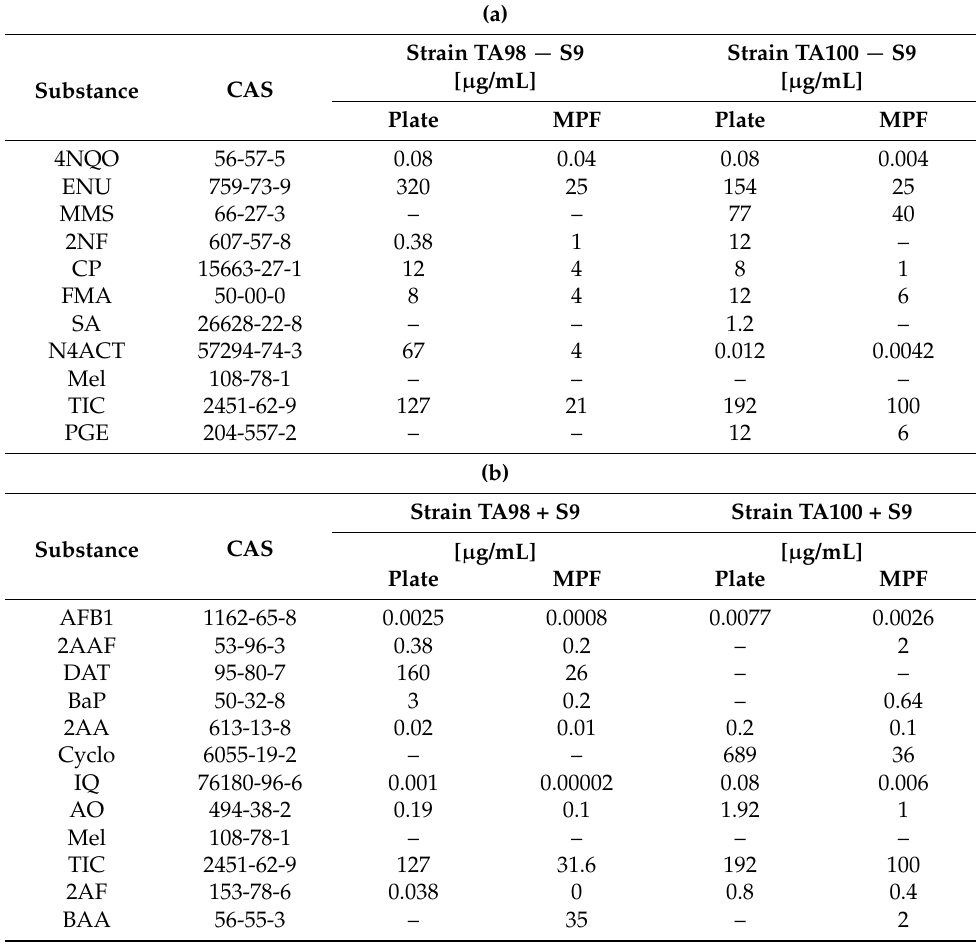
Table 2. Comparison of the Ames MPF™ protocol with the standard pre-incubation Petri-dish agar-based Ames test. Each substance was tested twice with the same dilution series and pre-culture. The concentration in µ g/mL refers to the substance concentration during the exposure step. Each substance was tested in eight concentrations in half logarithmic dilution steps. ( a ) test results without metabolic activation, ( b ) results including metabolic activation with PB/ßNP induced